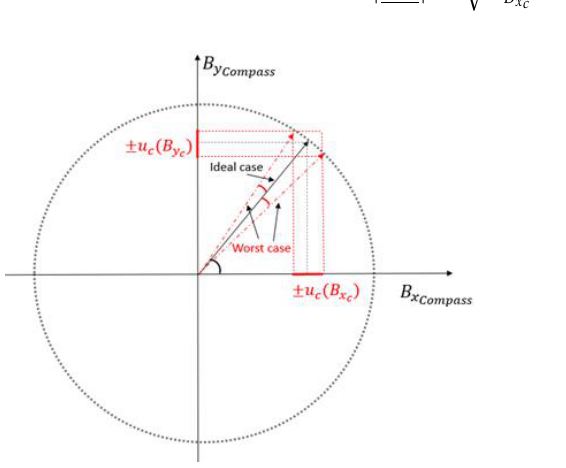
⁡ and 𝐵 𝑦 have values equal to the and B y have values equal to the 𝑐𝑜𝑚𝑝𝑎𝑠𝑠 𝑐𝑜𝑚𝑝𝑎𝑠𝑠 compass compass (cid:1) ) respectively. 𝑐 c